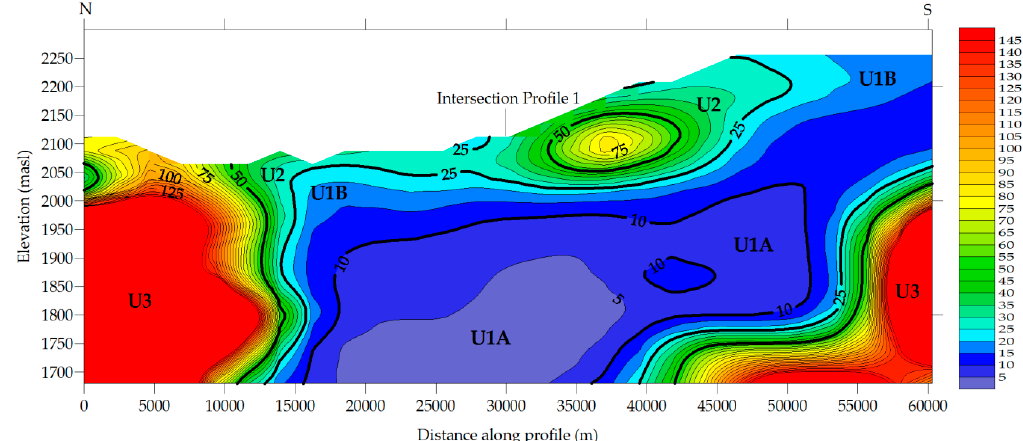
Figure 11. Two dimensional time–domain electromagnetic models along the North–South Section 2.